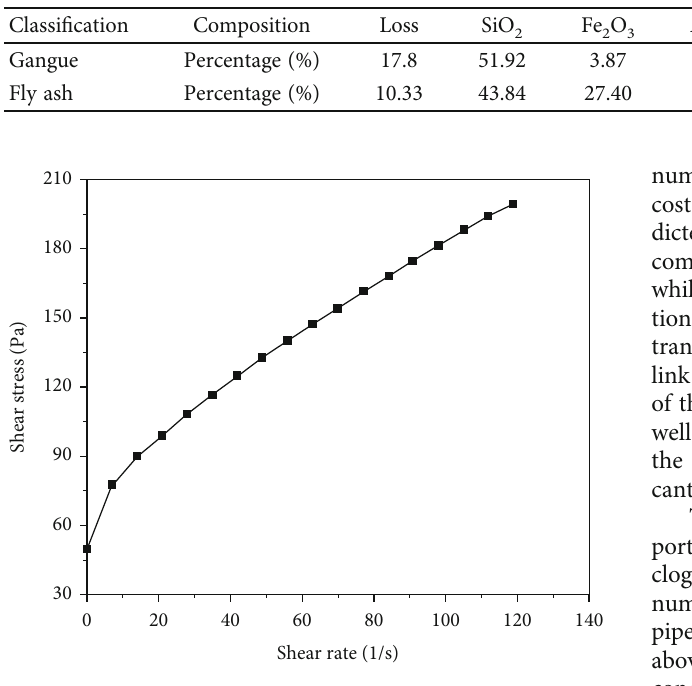
Figure 3: Rheological features of slurry.